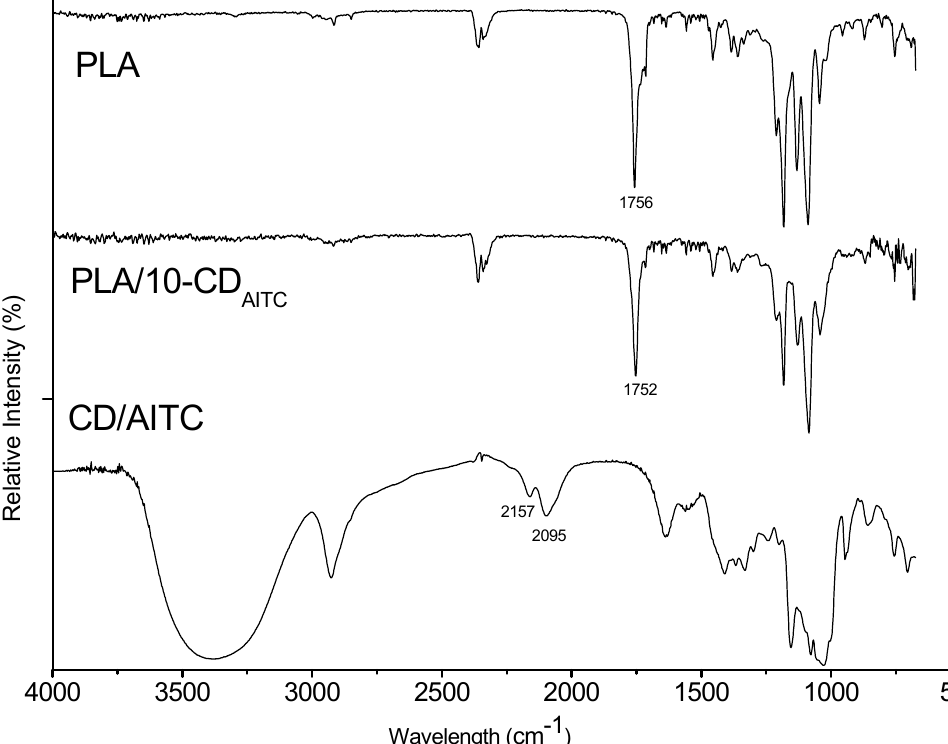
Figure 3. Fourier transformation infrared spectroscopy curves of the β -CD/AITC and PLA film with and without 10% β -CD/AITC.